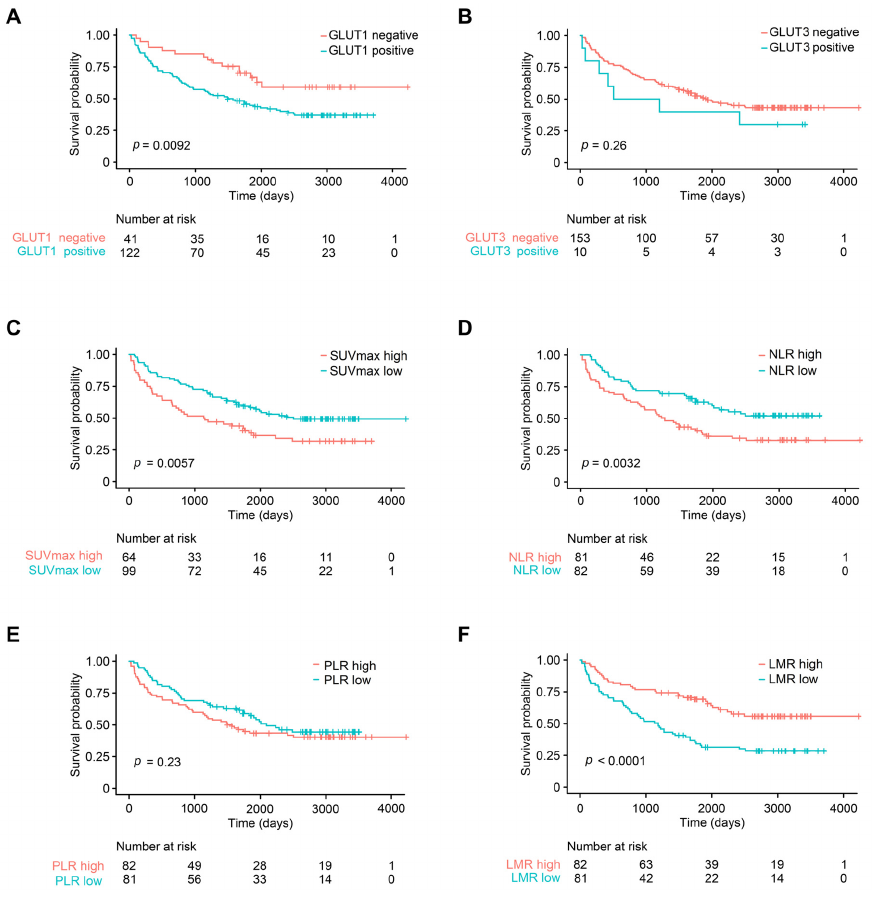
Figure 2. Kaplan–Meier survival curves of different parameters in patients with non-small cell carcinoma. ( A ) GLUT1 expression, ( B ) GLUT3 expression, ( C ) FDG-PET SUV max , ( D ) neutrophil– lymphocyte ratio (NLR), ( E ) platelet–lymphocyte ratio (PLR), and ( F ) lymphocyte–monocyte ratio (LMR). FDG-PET SUV max , fluoro-D-glucose-positron emission tomography maximum uptake